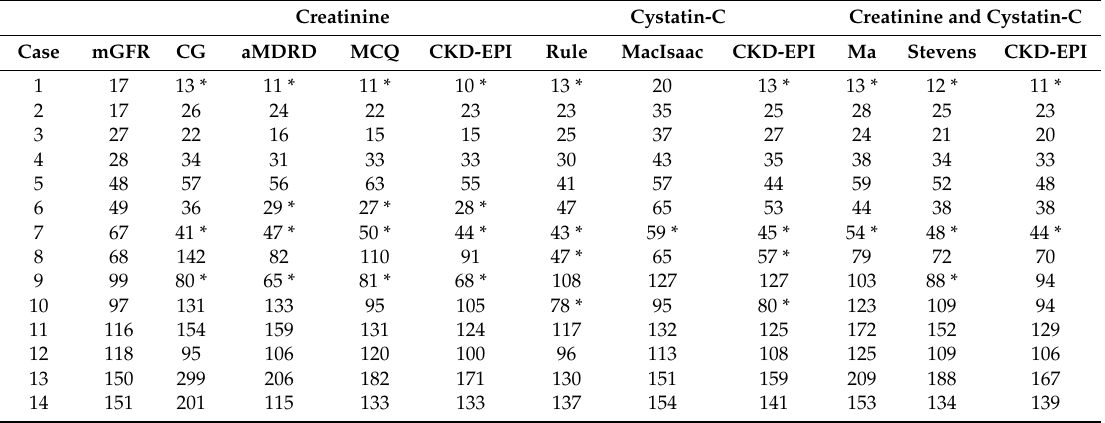
Table 3. Estimated and measured glomerular filtration rate (GFR) in a representative group of 14 diabetic subjects. Creatinine Cystatin-C Creatinine and